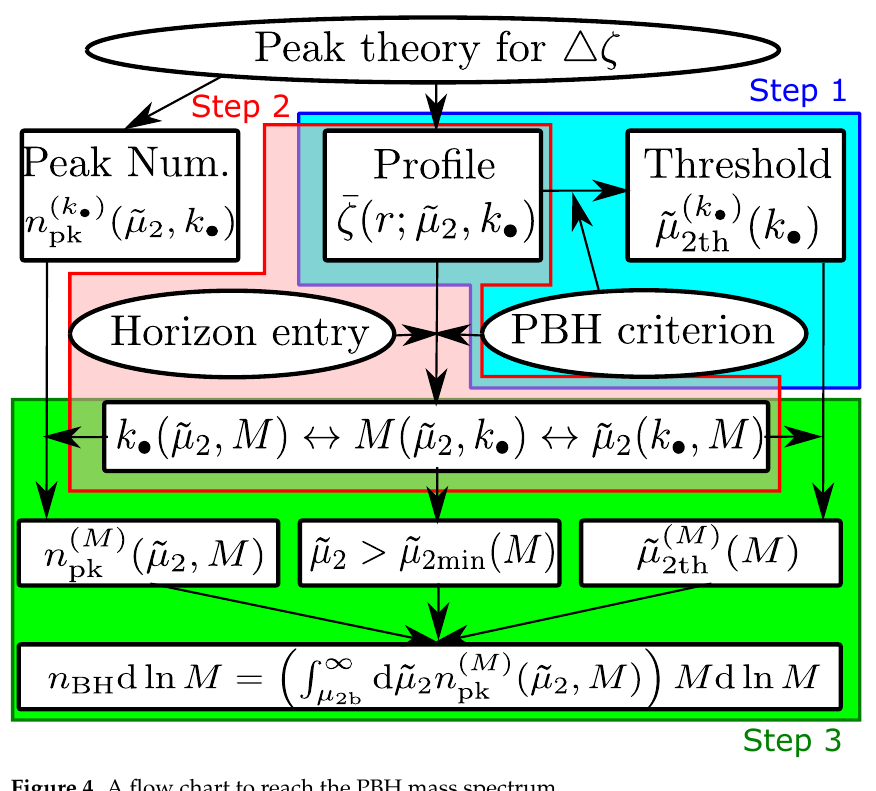
Figure 4. A flow chart to reach the PBH mass